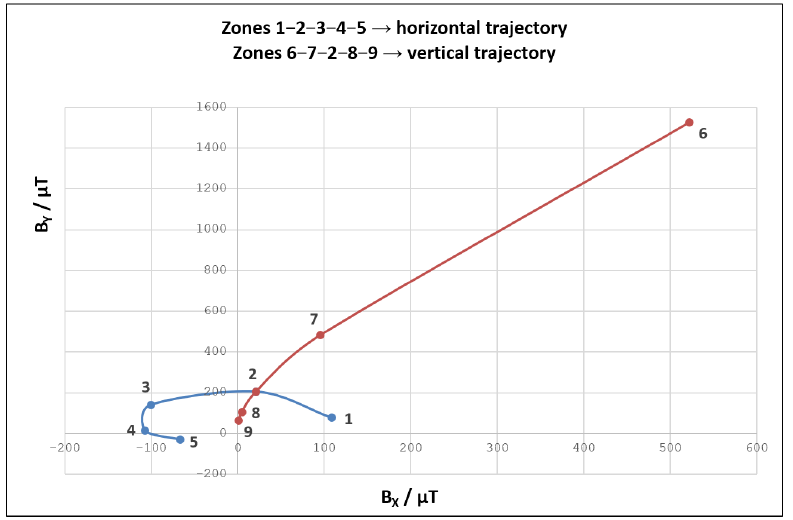
Figure 14. Magnetic field values obtained for 9 selected zones within the canvas utilized in the curve fitting